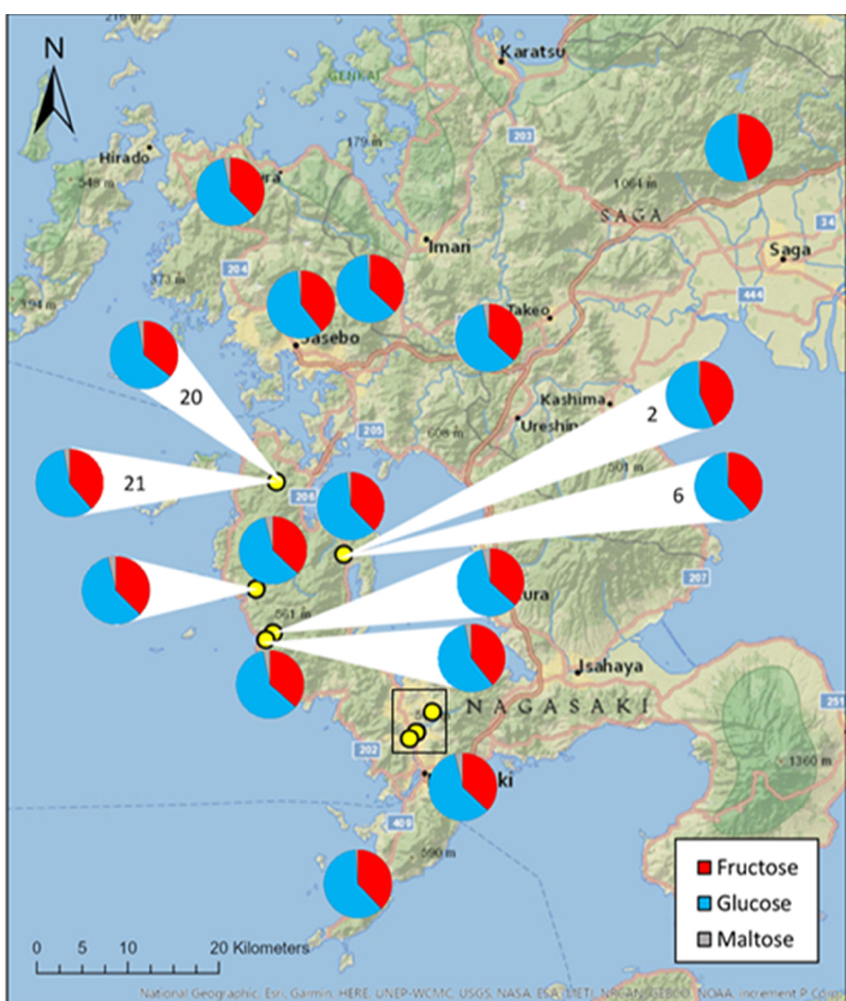
Figure 2. Proportion of fructose, maltose and glucose in honey samples collected from 22 Apis species hives across Kyushu, Japan. Yellow dots represent hives where pie chart could not be placed directly in the correct location. Where multiple hives had the same location, pie charts are labelled with hive number. Sugar proportions were calculated using HPLC. Clustered hives located in Nagasaki, within the black rectangle, can be found in Figure S1.